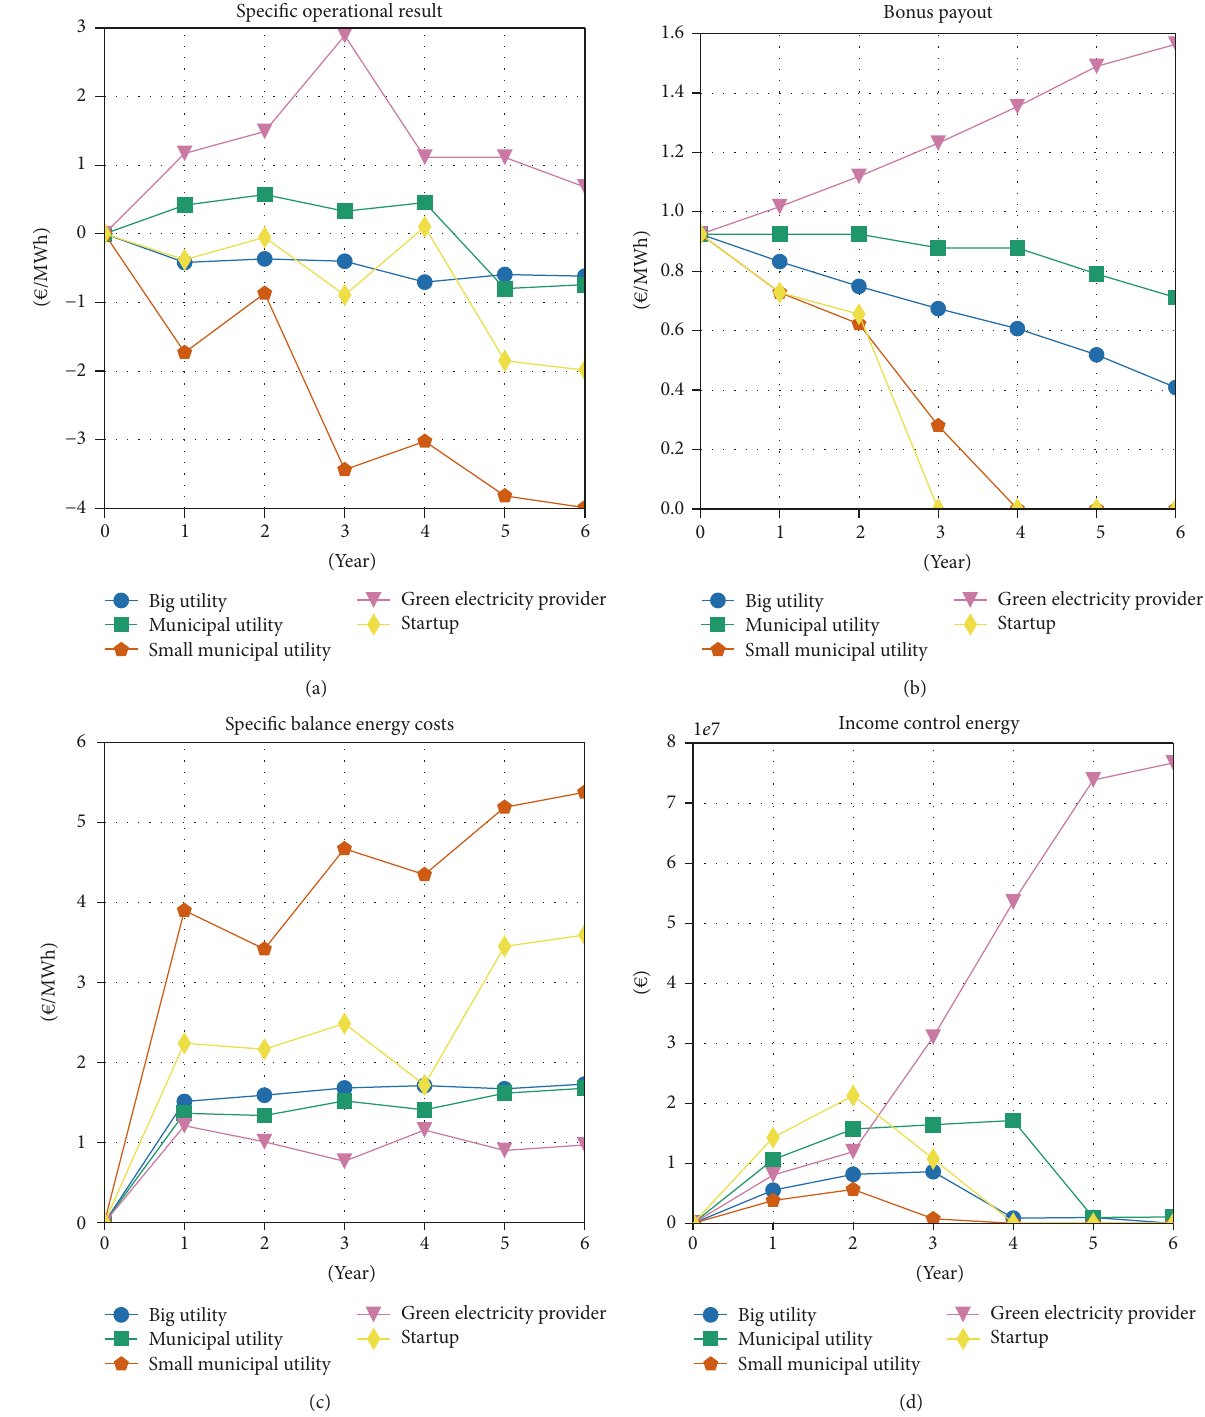
Figure 6: Specific operational results, bonus payouts, balance energy costs, and income from the control energy market for all 5 marketers in the second scenario with reduced management